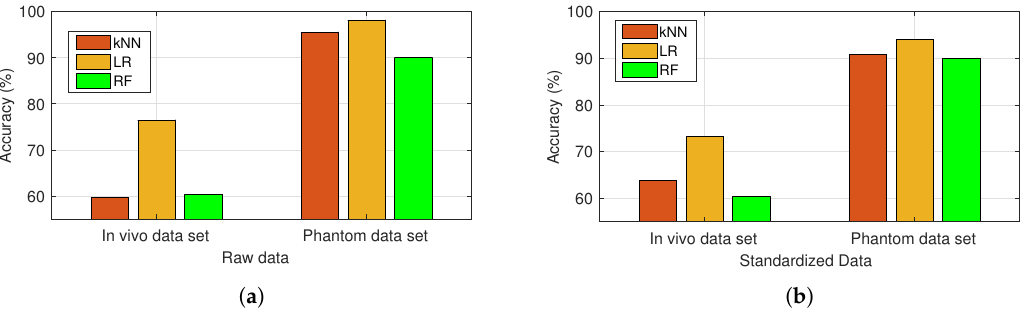
Figure 7. Comparison of k-nearest neighbors (kNN), logistic regression (LR), and random forest (RF) algorithm accuracies with leave one out (LOO) scheme: ( a ) application to raw data obtained from in vivo and phantom dielectric property measurements; ( b ) application to standardized data obtained from in vivo and phantom dielectric property measurements.